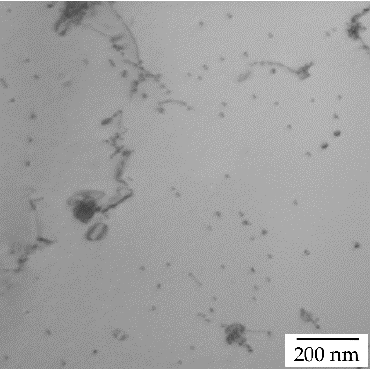
Figure 15. TEM image of the AlMnYbZr HT alloy after isochronal treatment up to 510 °C — see secondary Al 3 (Yb,Zr) particles.